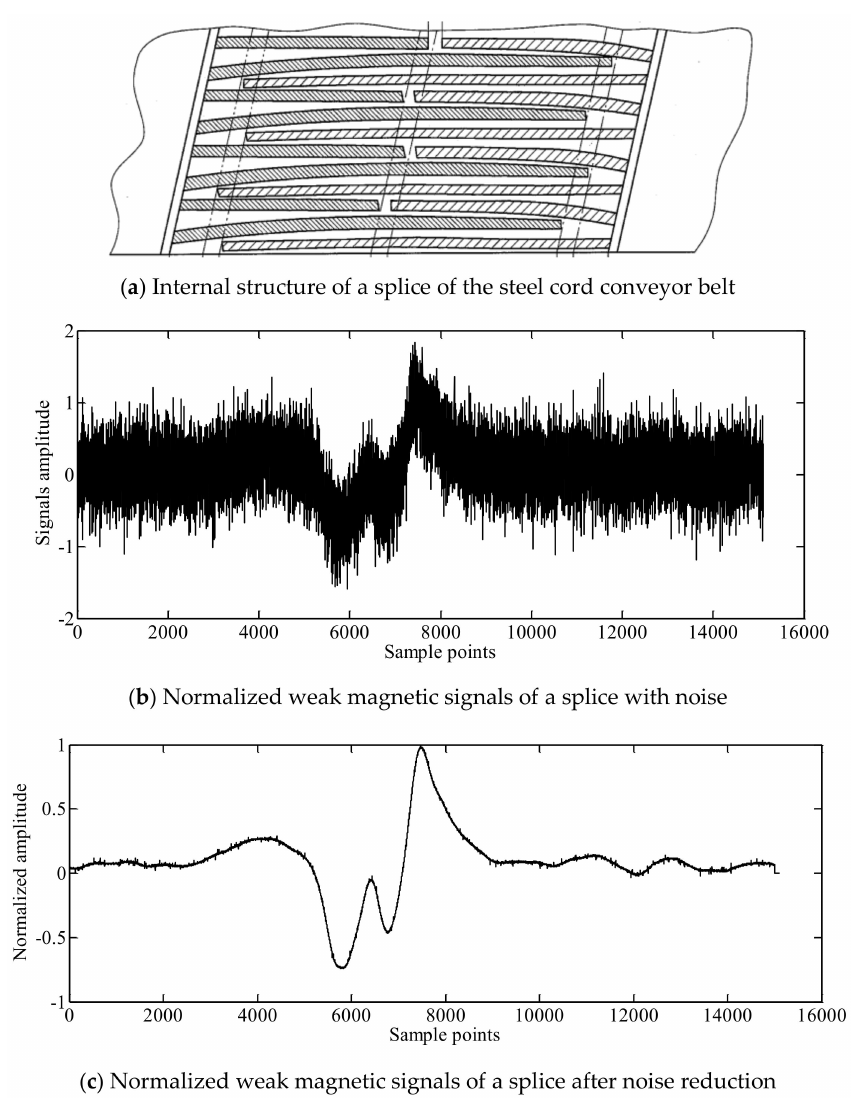
Figure 11. Normalized weak magnetic signals of a splice before and after noise reduction.